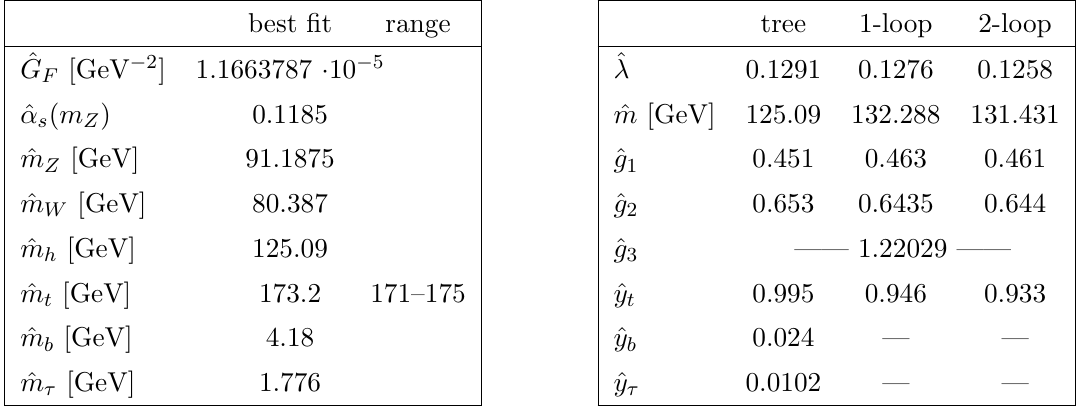
Table 2 . Left table: best (cid:12)t values of the quantities used as inputs in the numerical analysis, while m t is varied in the range speci(cid:12)ed. Right table: matching values for the SM parameters at (cid:22) = m t obtained from the expressions in appendix A in ref. [44] with the inputs on the left when m t = 173 : 2